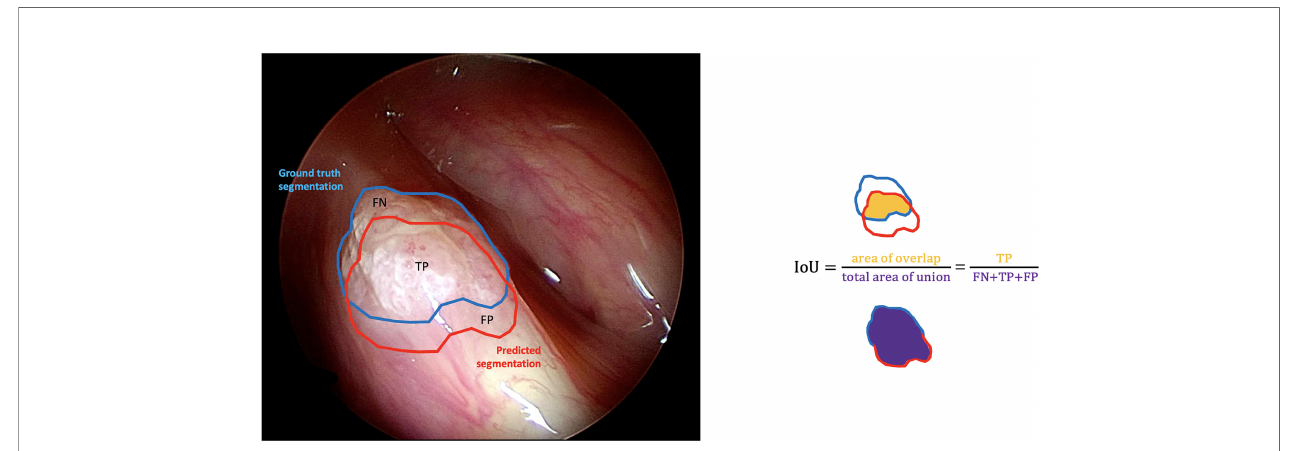
FIGURE 4 | Graphical representation of the intersection over union (IoU) calculation on a white light right glottic cancer intraoperative videoframe. The boundary traced in light blue represents the ground truth segmentation provided by an expert clinician, while the red one represents the model prediction. The IoU is calculated by dividing the overlapping area (containing the true positive pixels) by the total area of union (encompassing the false negative, true positive, and false positive pixels).